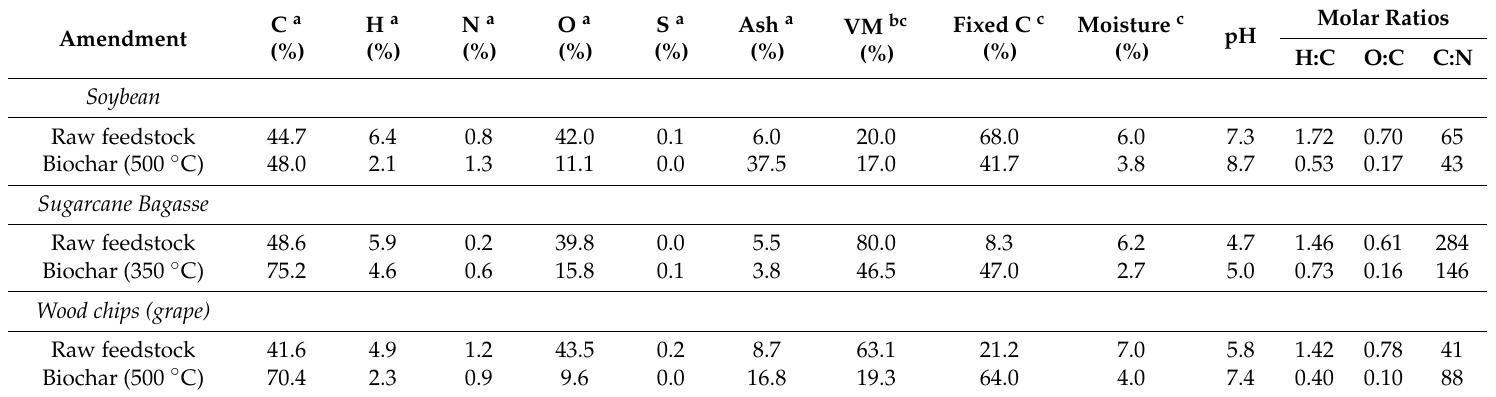
Table 2. Proximate and ultimate analyses of the soil amendments